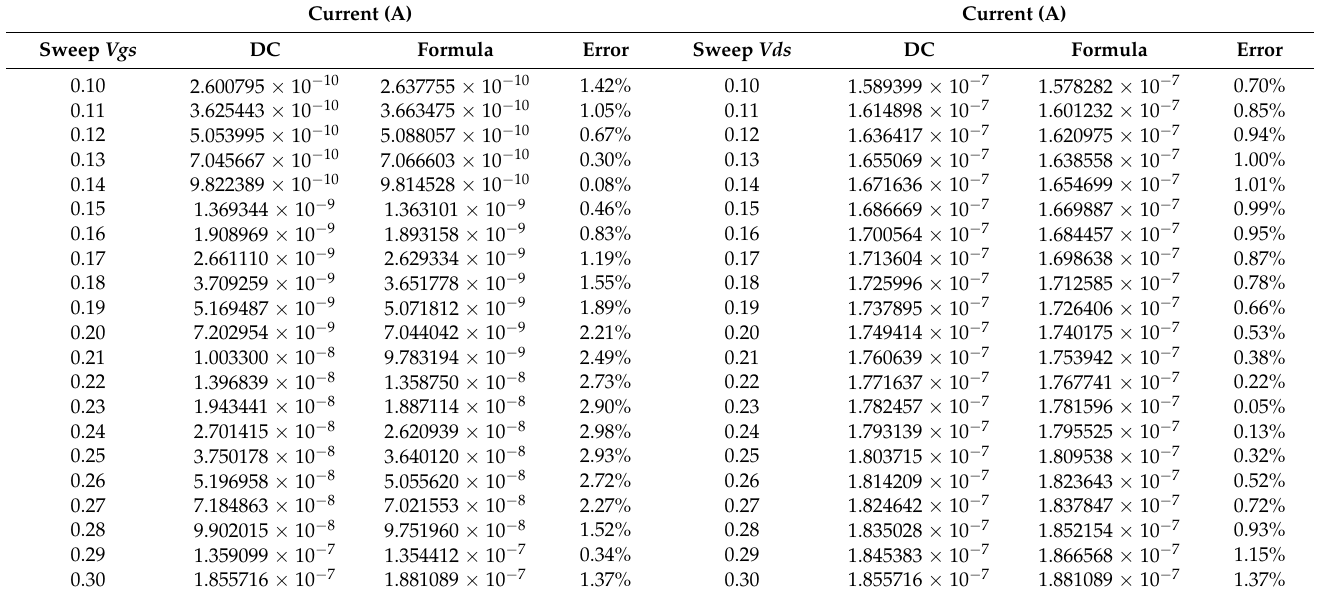
Table A4. Size 3: Current data compared with simulation results.